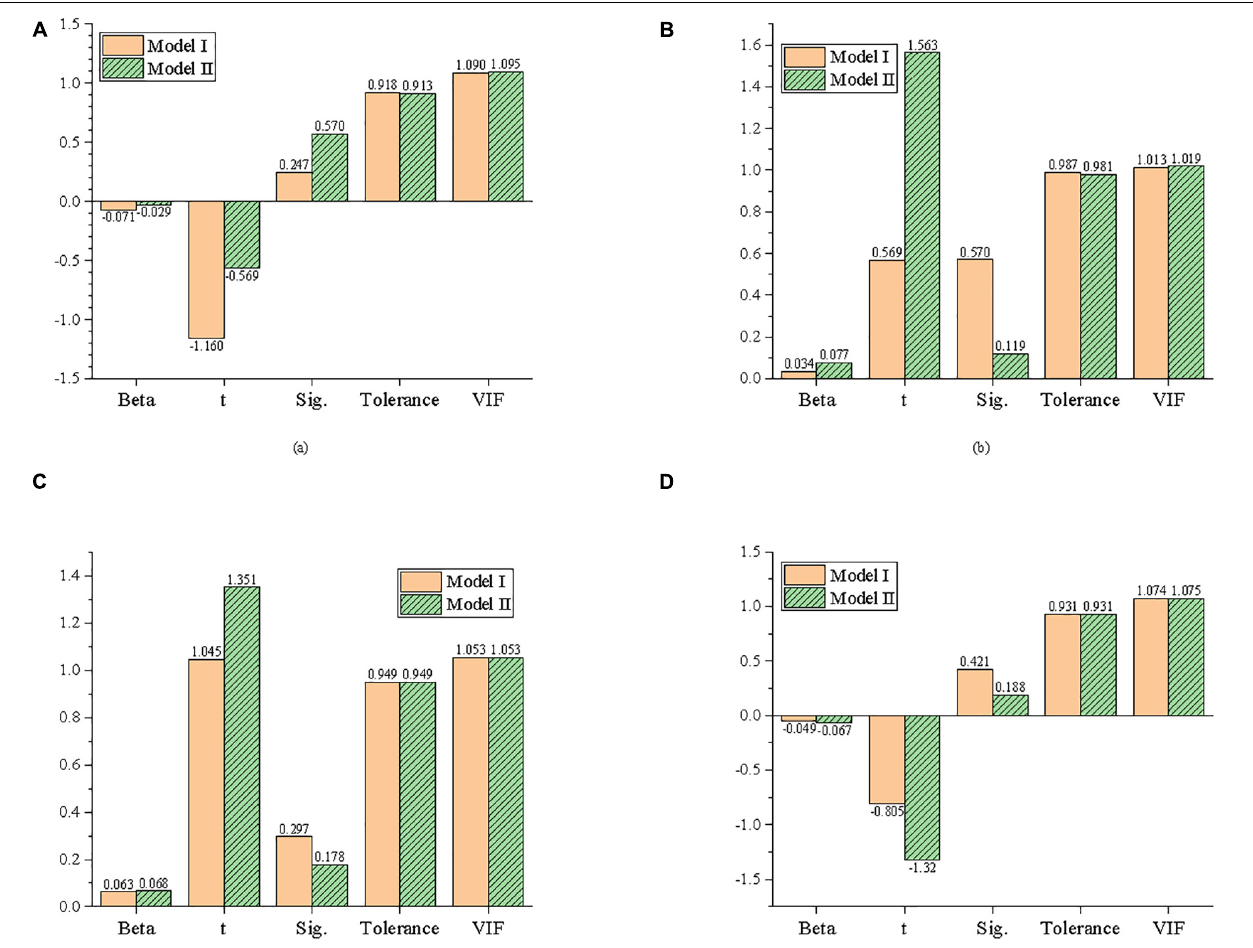
FIGURE 9 | Regression analysis of the effect of model innovation on entrepreneurial self-efficacy. (A) Educational background, (B) gender, (C) age, and (D) company size.